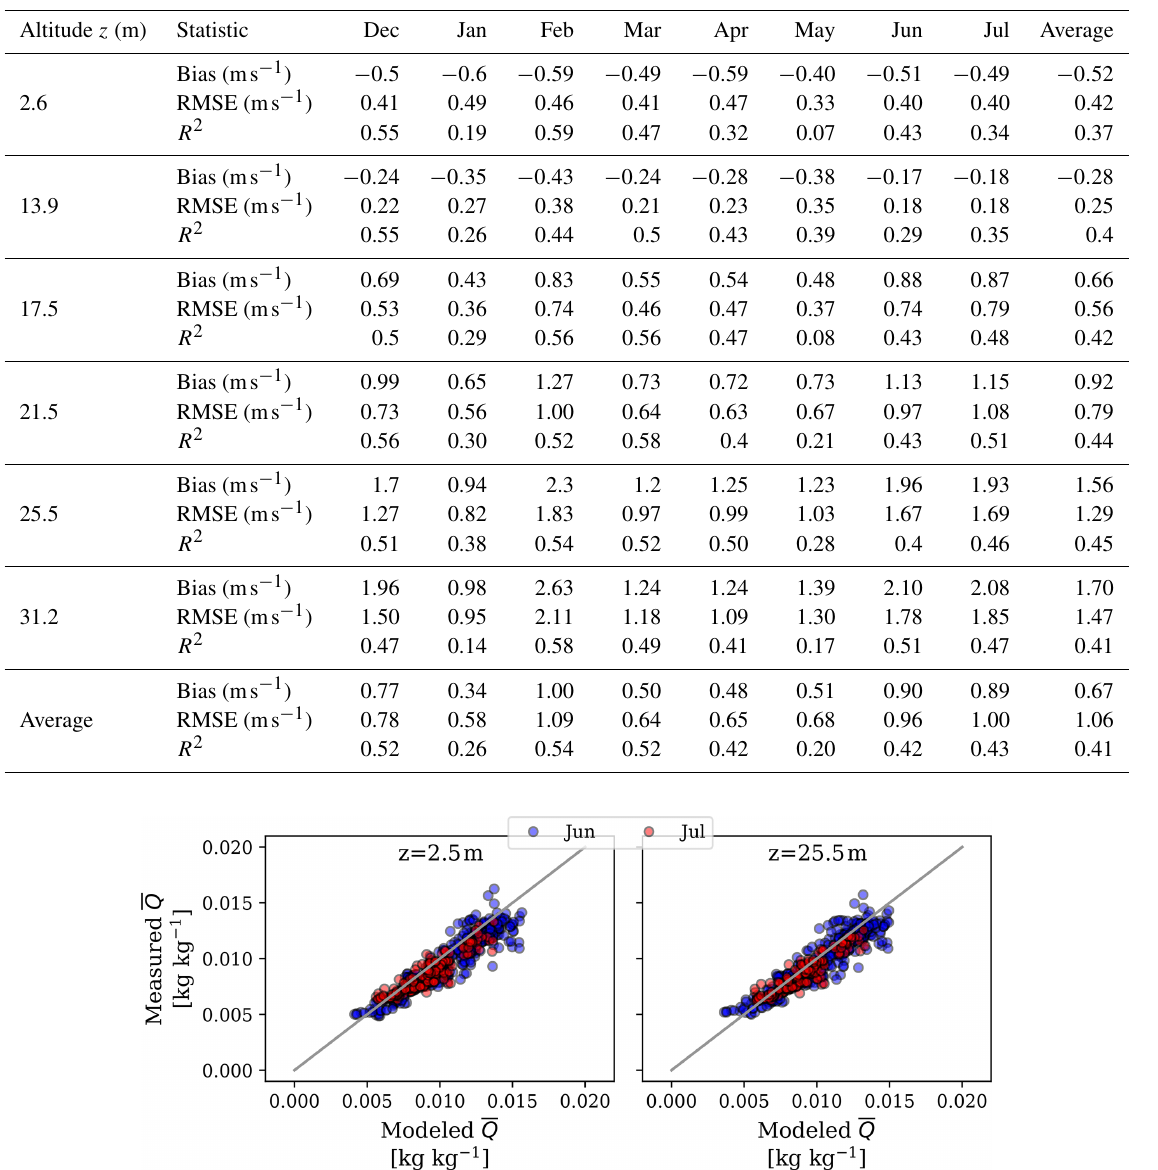
Table 3. Bias (ms − 1 ), RMSE (ms − 1 ), and R 2 (–) for VCWG predictions of wind speed against the BUBBLE observations for different altitudes and months.